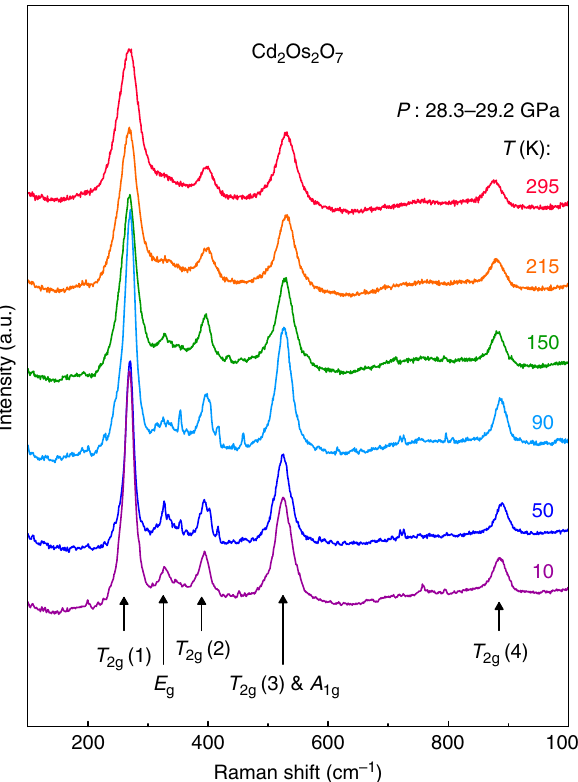
Fig. 2 Optical Raman scattering. Raw Raman spectra of Cd 2 Os 2 O 7 at various temperatures from 10 to 300 K and our highest measured pressure, P ~ 29 GPa. We only observe the six modes consistent with the Fd-3m space group. The T 2g (3) and A 1g modes merge under their broadened